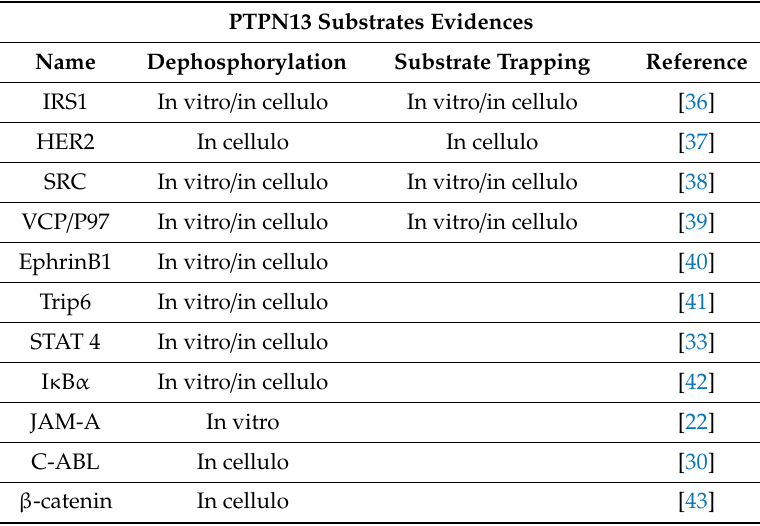
Figure 2. PTPN13 is involved in multiple signaling pathways. PTPN13 in green: Tumor suppressor role; PTPN13 in red: Pro-tumoral role. Arrow pointing to P: PTPN13 e ff ects mediated by its phosphatase activity. TLR: Toll-like receptor, LRP / Fz: lipoprotein receptor-related protein / Frizzled. Table 2. PTPN13